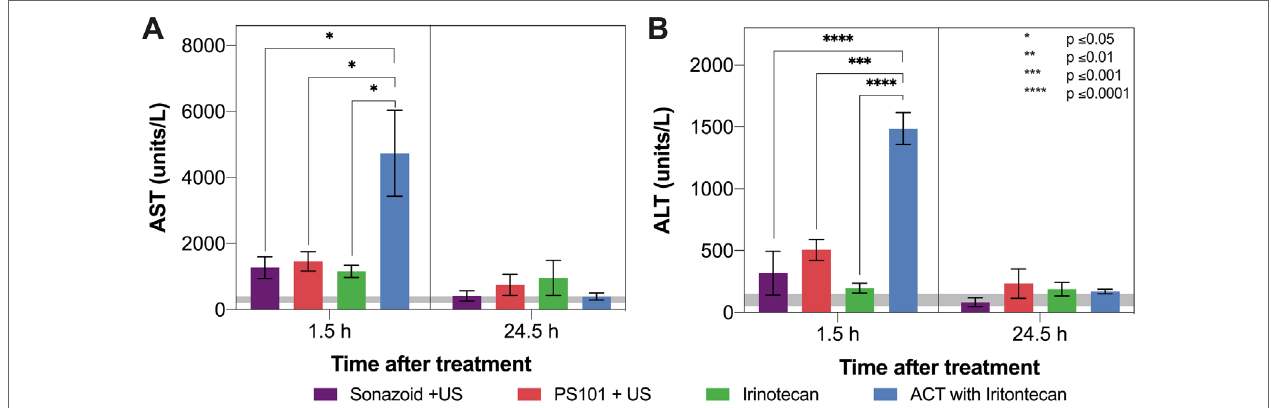
FIgURe 6 | Aspartate aminotransferase (AST) (Panel A ) and alanine aminotransferase (ALT) (Panel B ) levels 1.5 and 24.5 h after treatment start. The grey horizontal bar shows normal values reported in literature. Only ACT with irinotecan 1.5 h after treatment start shows a significant difference to any other groups. Decreased levels were observed for all groups after 24.5